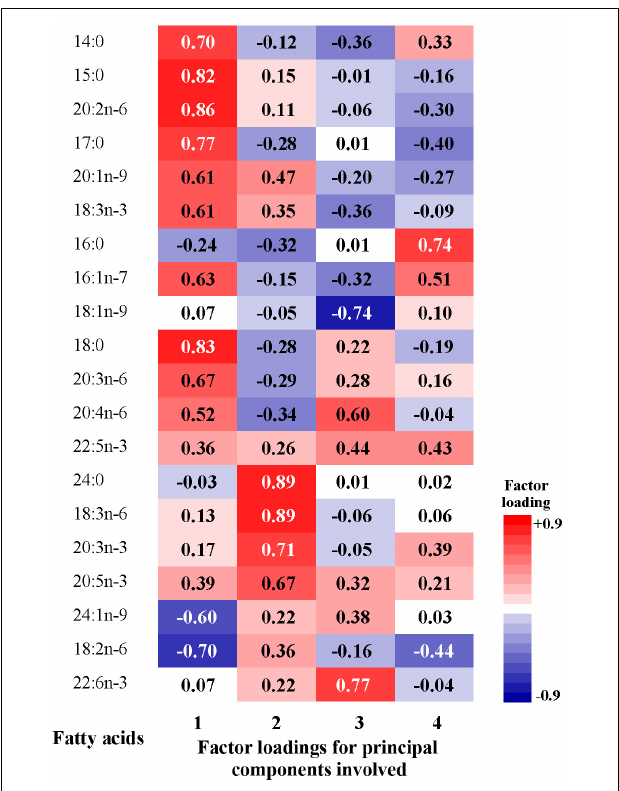
FIGURE 3 | Factor loadings of the 20 fatty acids for the 1st to 4th principal components. The closer the factor loading (absolute value) is to 1, the greater the influence of single fatty acid on the